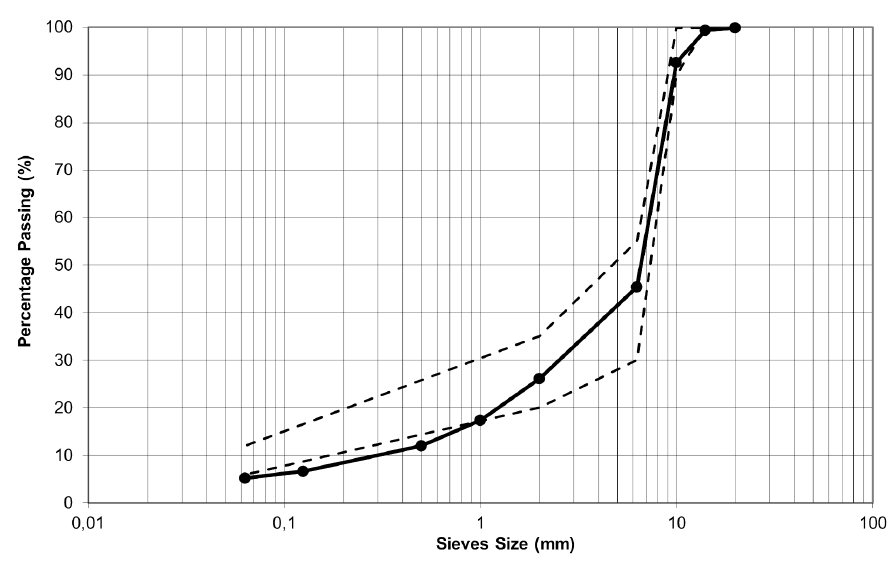
Figure 1. The 10 mm SMA grading